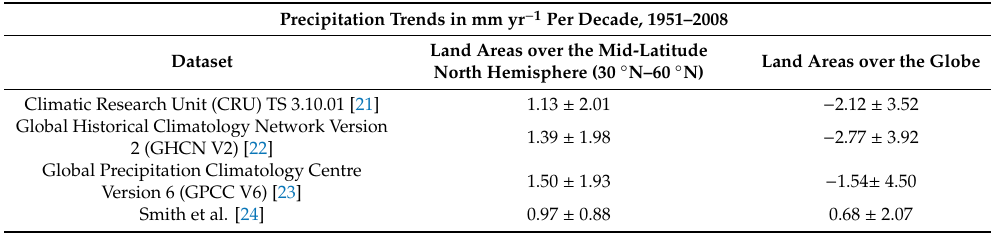
Table 6. Linear trend in the mid-latitude northern hemisphere (30 ◦ N–60 ◦ N) and annual global land precipitation, 1951–2008 (IPCC,